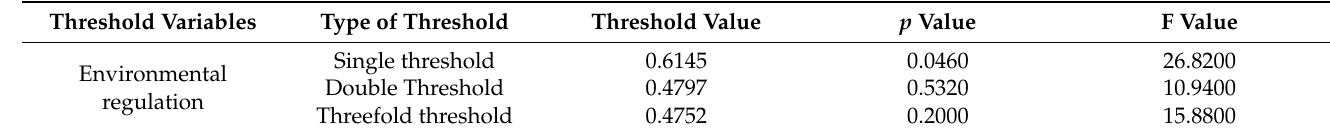
Table 10. Threshold effect test and threshold